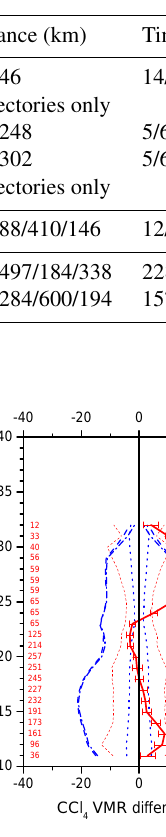
Figure 8. Same as Fig. 7 but for the OR part of the MIPAS mission. Figure 7. Intercomparison between MIPAS-B and MI- PAS/ENVISAT (MIPAS-E) CCl4 VMR. Results for the FR part of the MIPAS mission. The plots show mean absolute and relative VMR differences of trajectory match collocations (red as follows. In the case of FR measurements: for pressures numbers) between both MIPAS sensors (red solid line) including between 80 and 190 hPa MIPAS/ENVISAT shows a statisti- standard deviation of the difference (red dotted lines) and standard cally significant negative bias of about − 10 % with respect error of the mean (plotted as error bars). Precision (blue dotted to MIPAS-B; this bias is however within the combined to- lines), systematic (blue dashed, dotted lines), and total (blue dashed tal error bounds. A statistically significant positive bias is lines) mean combined errors calculated according to the error (cid:16)q (cid:17) also evident for pressures smaller than 25 hPa. It increases + σ 2 σ 2 summation are also displayed. For MIPAS − E MIPAS − B with altitude and quickly becomes incompatible with the to- further details on the error calculation, see Wetzel et al. (2013). tal combined error. This bias can be at least partly explained by the selection of different microwindows used during the retrieval process of both MIPAS sensors. This bias, however, is not a major concern because it is localized at the upper end of the retrieval range. In this region the predicted uncer- tainty is so large that the linear approximation of the error propagation theory may easily fail to explain the discrepan- cies between the measurements of the two instruments. In case of OR measurements: for pressures between 150 and 190 hPa MIPAS/ENVISAT shows a statistically significant positive bias of about + 10 % with respect to MIPAS-B; this bias is however within the combined total error bounds.